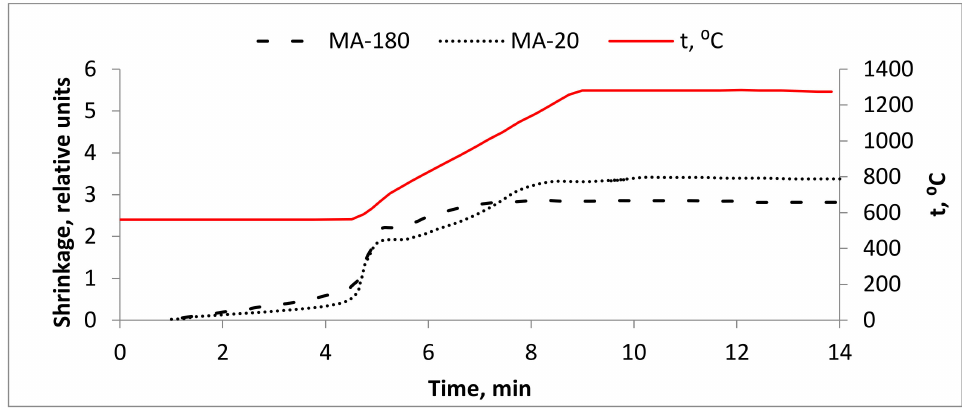
Figure 3. Dynamics of linear shrinkage of reaction compositions based on Ti-Al-Nb in the process of SPS at a temperature of 1300 ◦